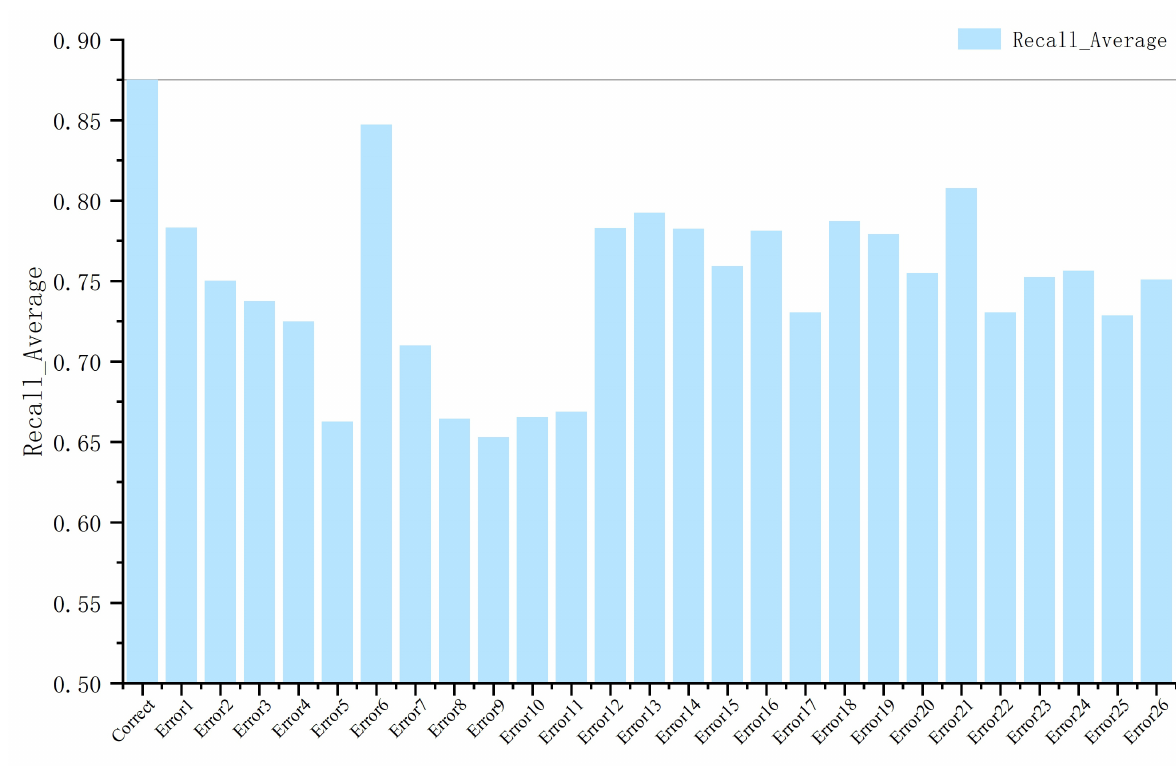
Figure A2. Average Recall under different cost sensitive factors α .